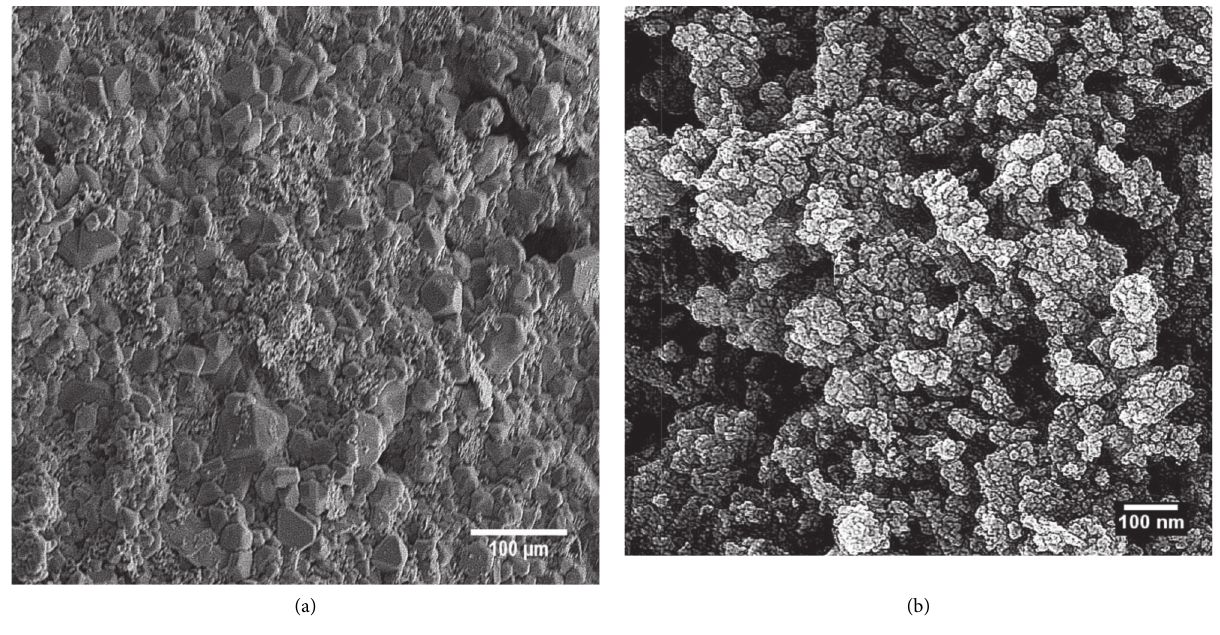
Figure 9: Structure of (a) COAT 1 and (b) COAT 2.